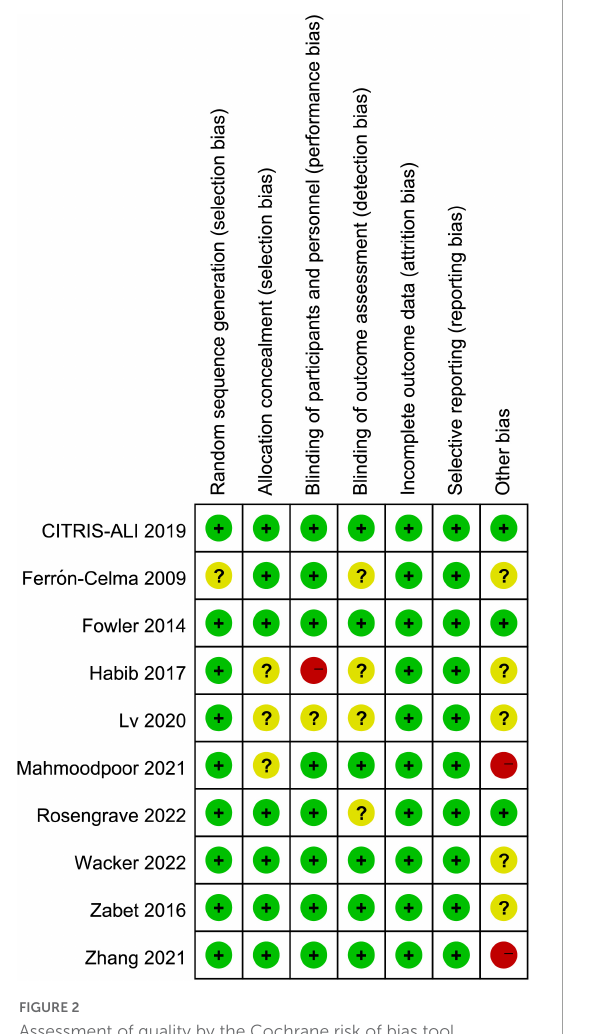
score. The IV vitamin C treatment was associated with a reduction in the duration of vasopressor (MD − 27.88, 95% CI − 49.84 to − 5.92, I 2 = 95%, Figure 4A ) among patients with septic shock. However, there was no significant difference in length of ICU stay (MD − 0.68, 95% CI − 2.13 to 0.78, I 2 = 74%, Figure 4B ) and SOFA score (MD − 0.05, 95% CI − 1.69 to 1.58, I 2 = 86%, Figure 4C ) between two groups. Notably, the results were greatly weakened by significant